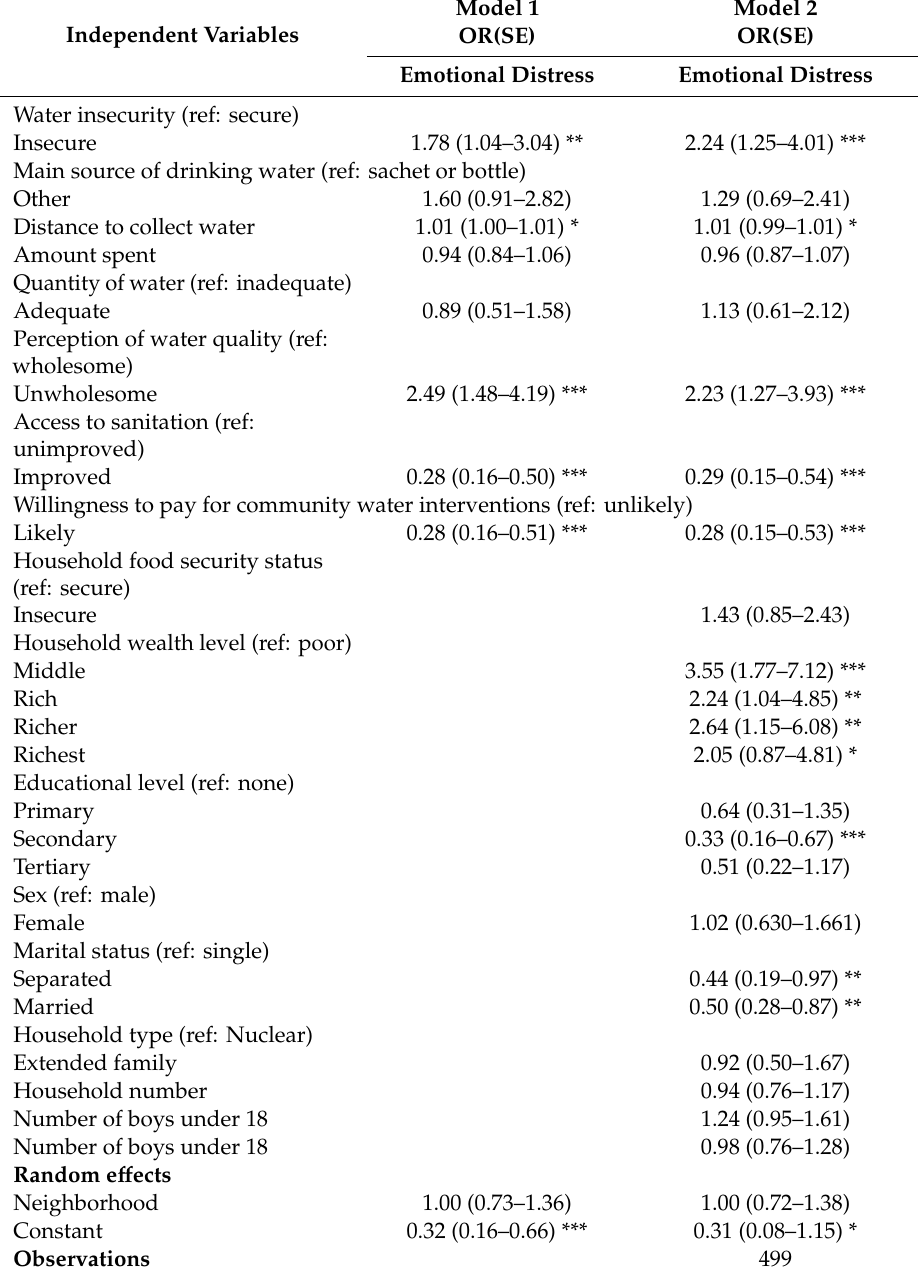
Table 3. Multivariate associations between emotional distress and selected independent